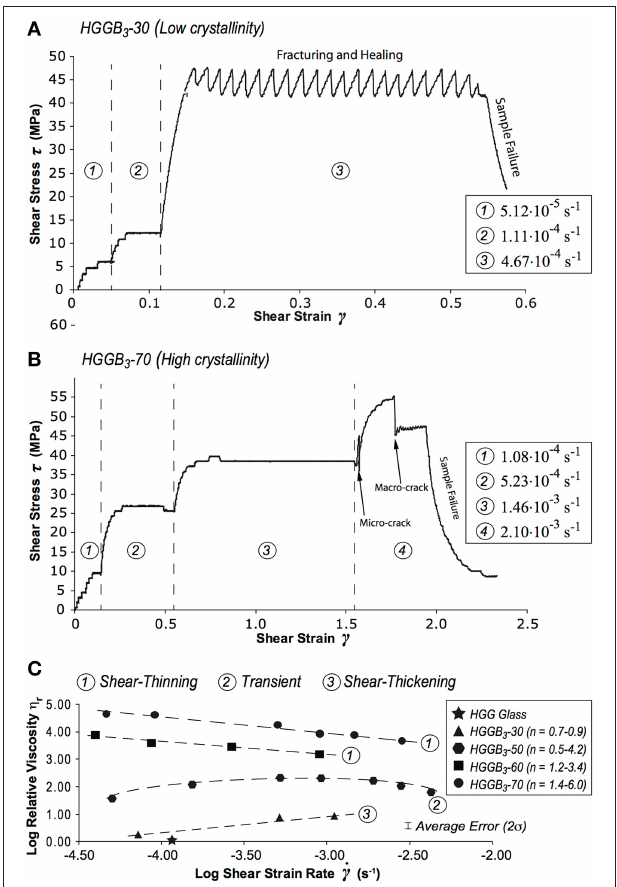
FIGURE 1 | Shear stress ( τ ) vs. strain ( γ ) diagrams for (A) low crystallinity (run P1271; φ = 0.24; β = 0.12) and (B) high crystallinity (run P1262; φ = 0.65; β = 0.09). (C) Logarithm of relative viscosity ( η rel = ratio between the apparent viscosity of the system composed of crystals, bubbles and melt, and the melt viscosity under identical chemical and physical conditions) vs. logarithm of ˙ γ diagram for representative experiments (from Pistone et al., 2012, modified) showing: shear-thinning ( φ > 0.44), shear-thickening ( φ < 0.44), and transient rheological behavior ( φ = 0.44), with corresponding range of stress exponent ( n ) values (as reported in Table 2